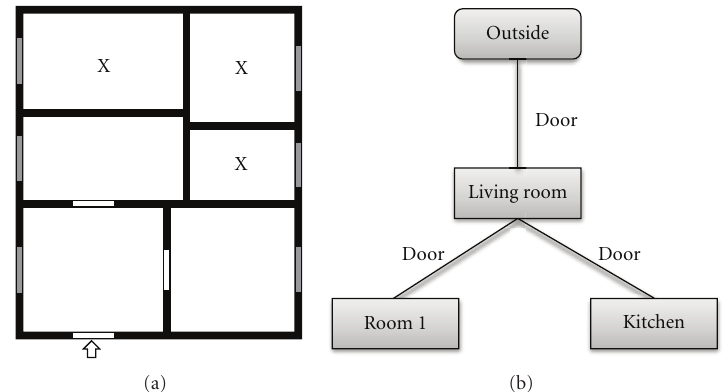
Figure 10: Example of floor plan (a) containing 2 nonconnected rooms (labeled with X) and its respective connectivity graph (b).